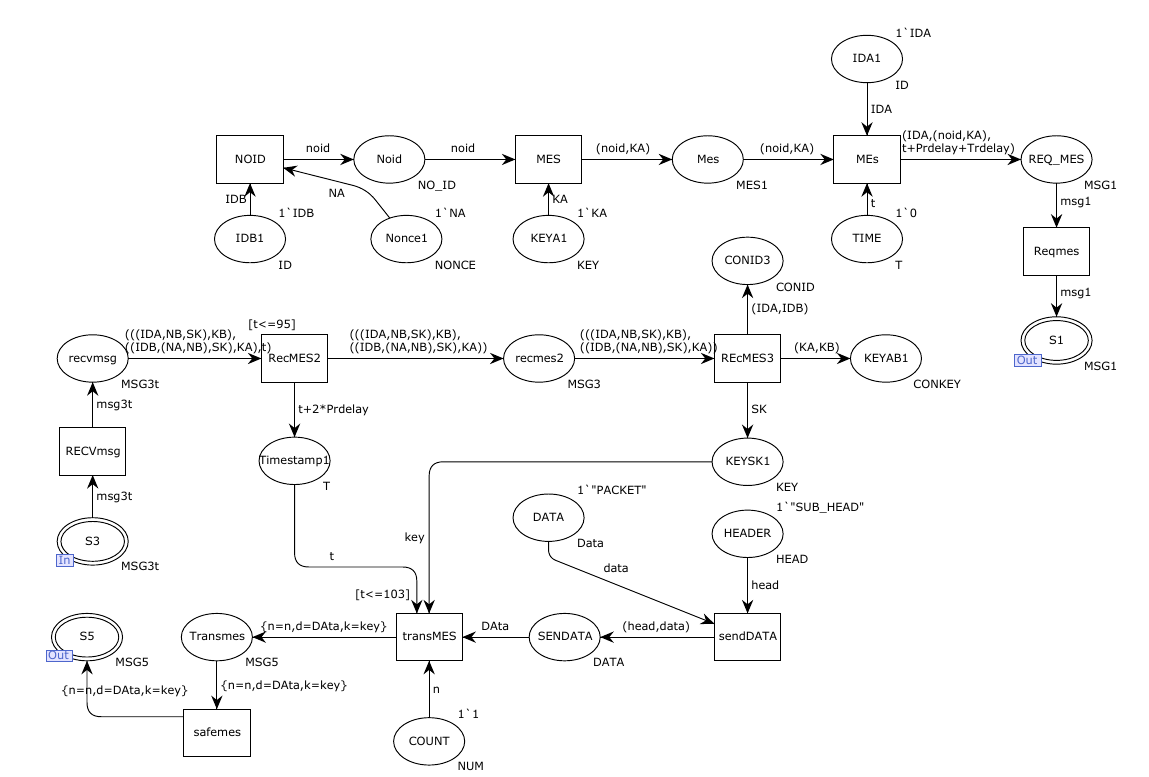
Figure 10. Internal model of the improved solution DCA.